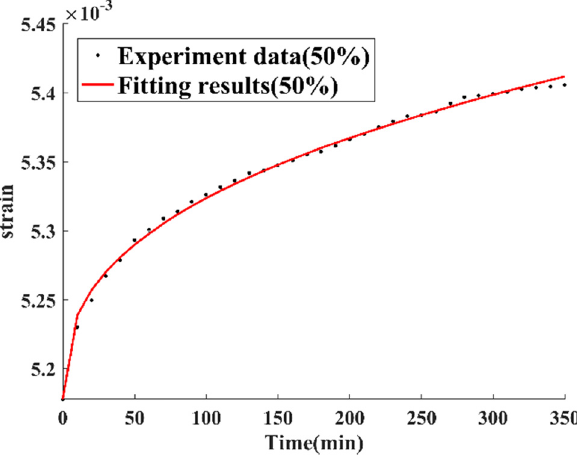
Figure 16: Fitting results based on the fractional de fi ned Maxwell model and 50% stress level.